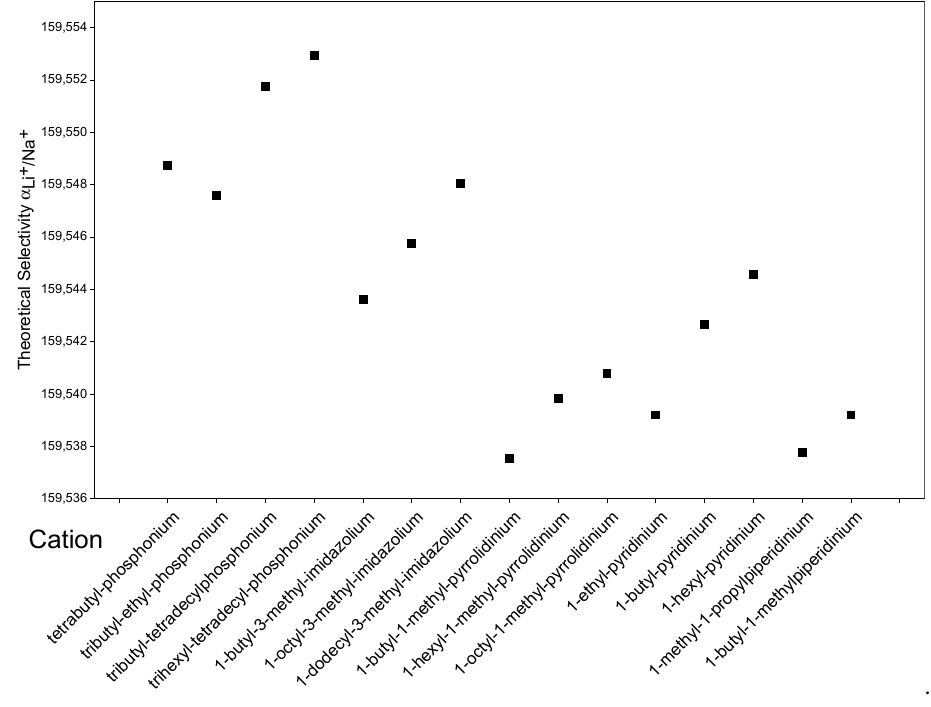
Figure 5. Effect of the cation in [TF 2 N] − based ILs on the 𝛼 (cid:3013)(cid:3036) (cid:3126) /(cid:3015)(cid:3028) (cid:3126) calculated by